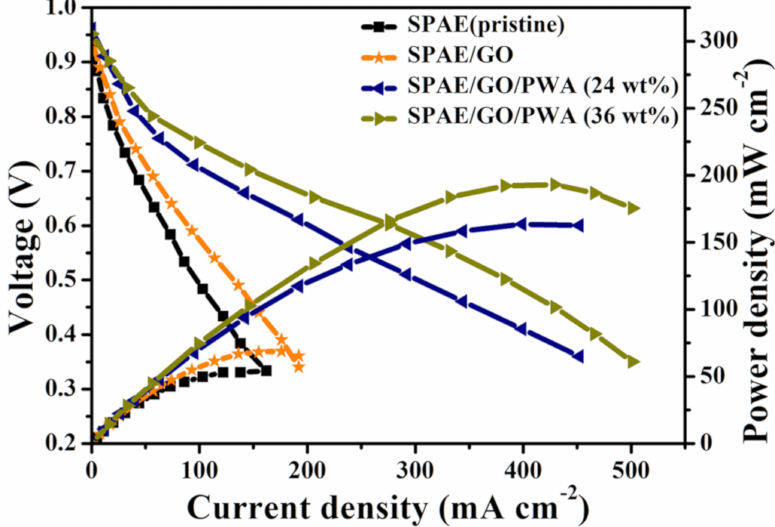
Figure 12. Polarization curves of SPAE composite membranes at 70 ◦ C under 100%